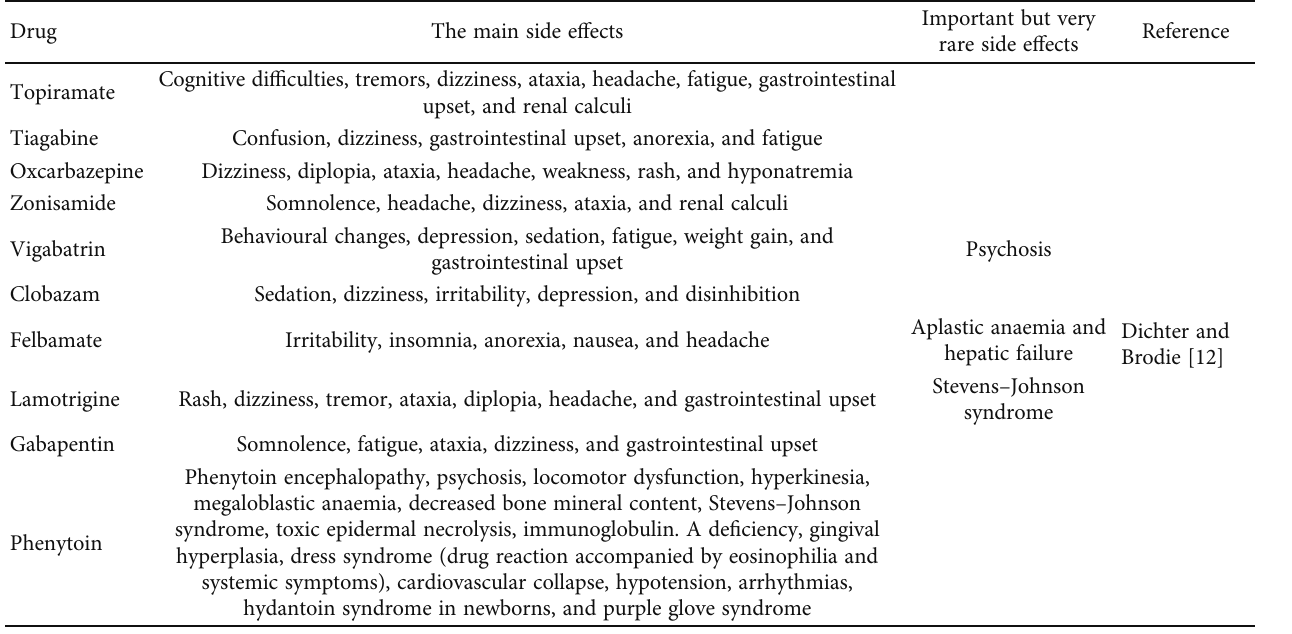
Table 1: Side e ff ects of various anti-epileptic drugs.